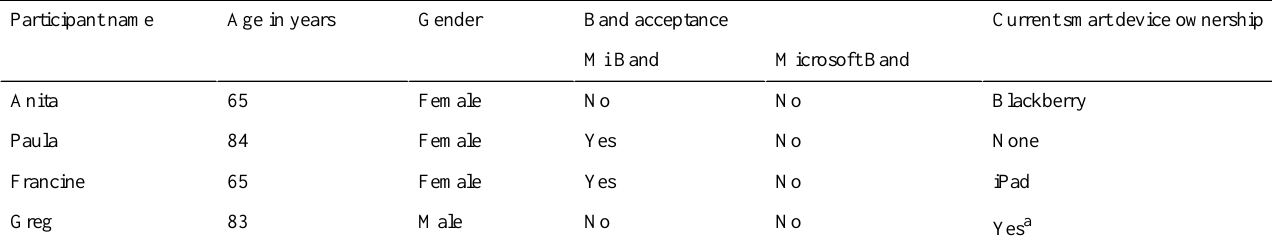
Table 8. Semistructured participant